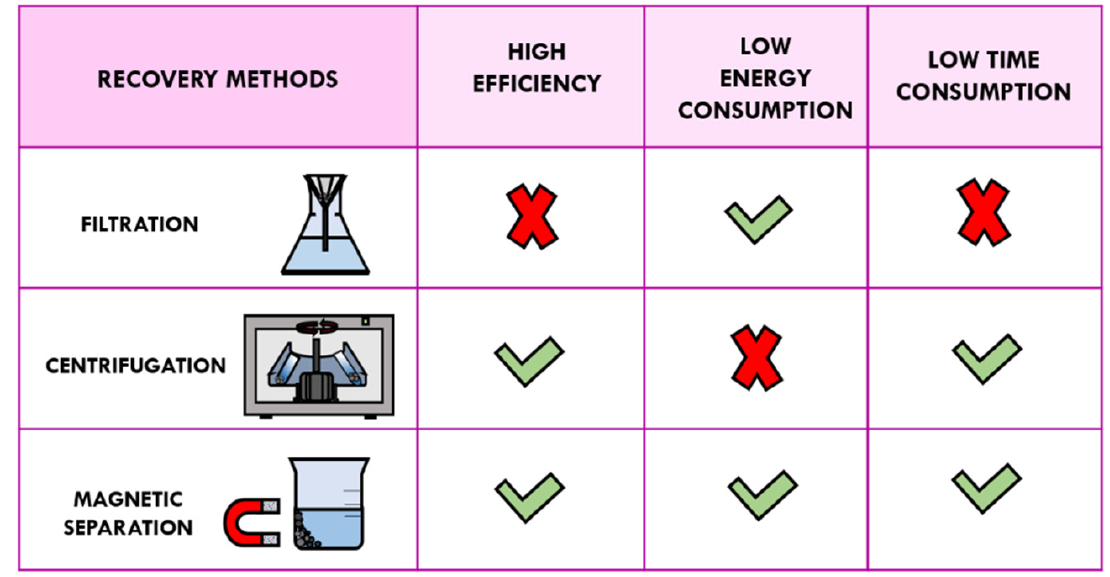
Figure 4. Comparison of recovery methods: filtration, centrifugation, and magnetic separation.